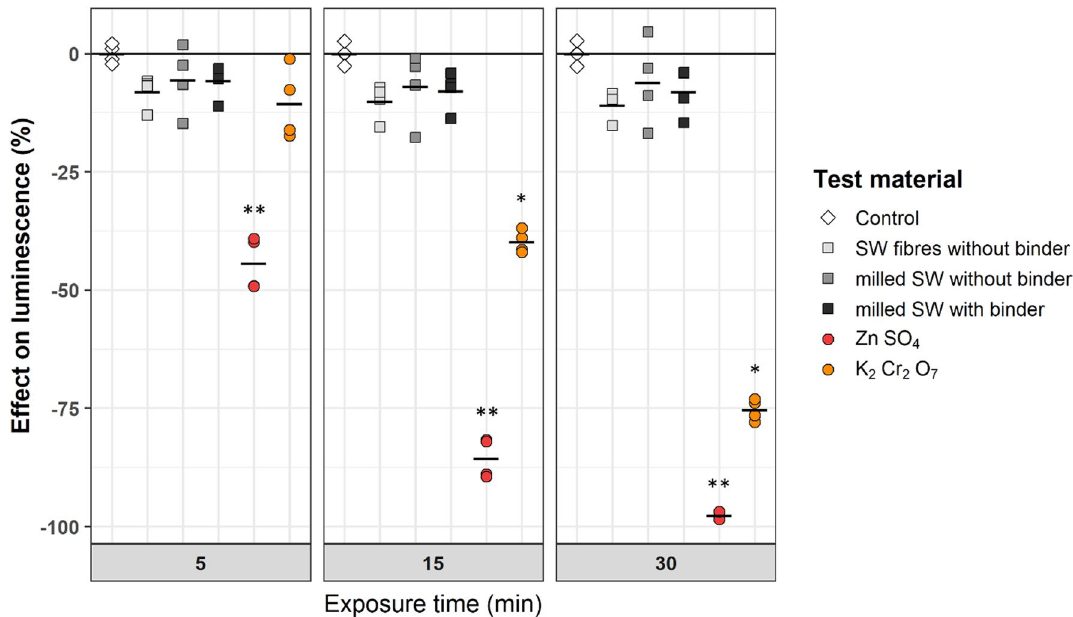
Fig. 3 Results of the bacterial bioluminescence inhibition test for the negative control (white diamond), the eluates (100 mg/L) of the three test materials (grey squares) and the positive controls (zinc sulfate and potassium dichromate; red and orange circles) after 5, 15 and 30 min of exposure, as individual values and means of n 4 replicates (black dash). Effects were calculated in comparison to the mean value of luminescence in the = negative control and positive effect values show luminescence stimulation, while negative values show luminescence inhibition. Asterisks denote significant differences between the treatments and the negative control (Dunn’s test: *: p < 0.05, **: p < 0.01)